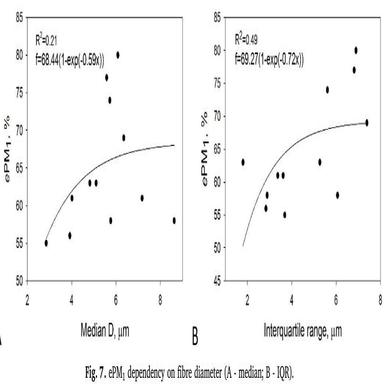
Effects of base mass (A) and packing density (B) on ePM1.